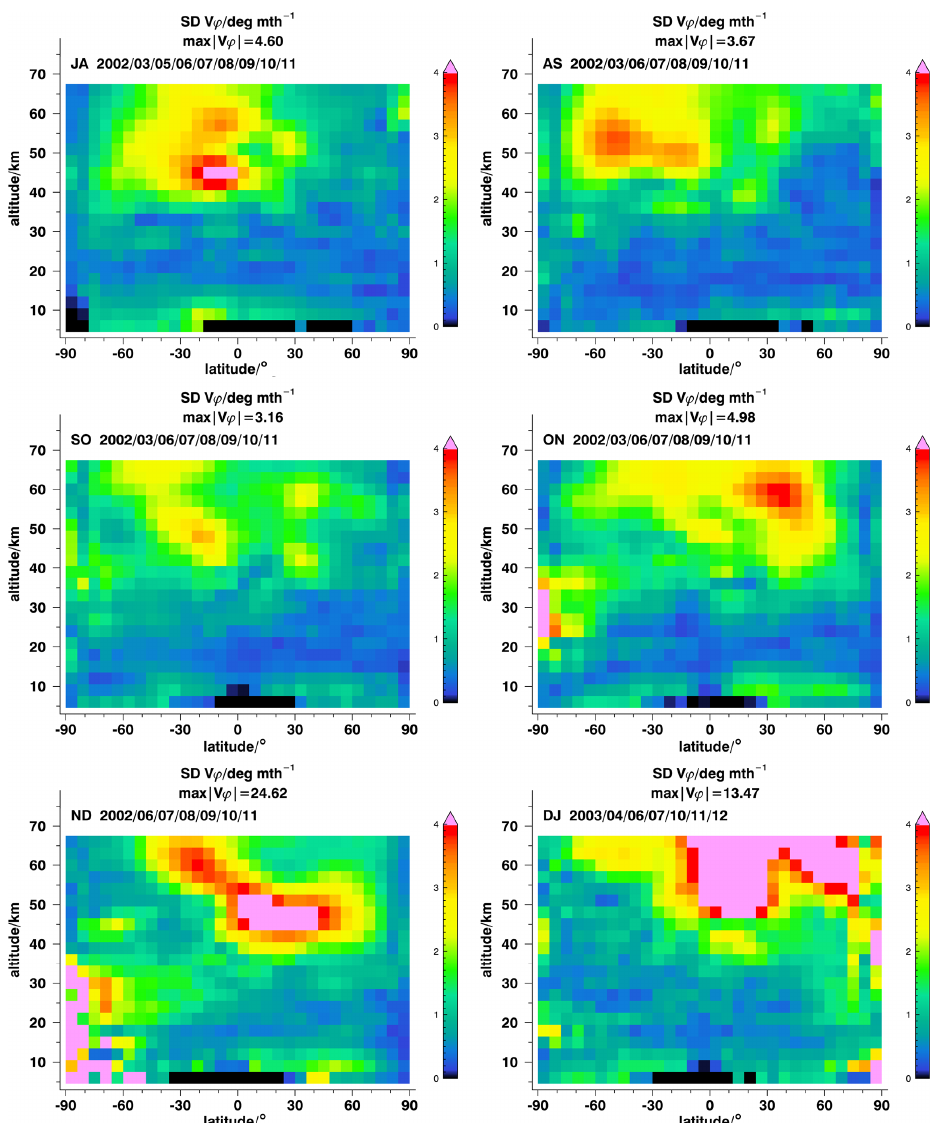
Figure 7. Interannual variability of the middle atmospheric meridional effective velocities in terms of sample standard variations from July–August (top left, JA) to December–January (bottom right,